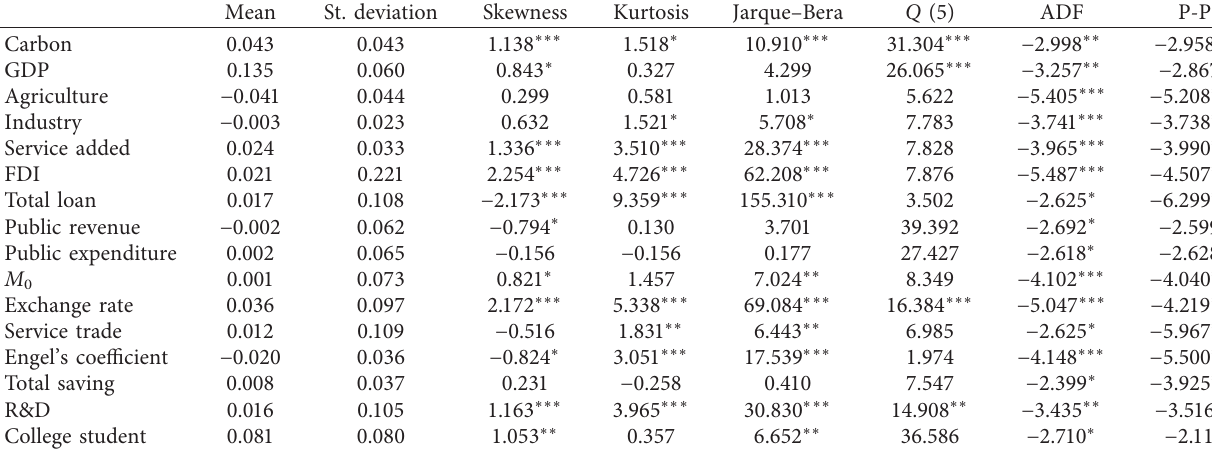
Table 2: Descriptive statistics for energy returns.